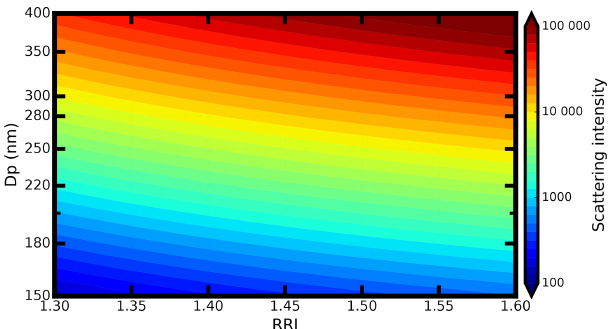
Figure 2. The distribution of the aerosol-scattering intensity at a different D p and different